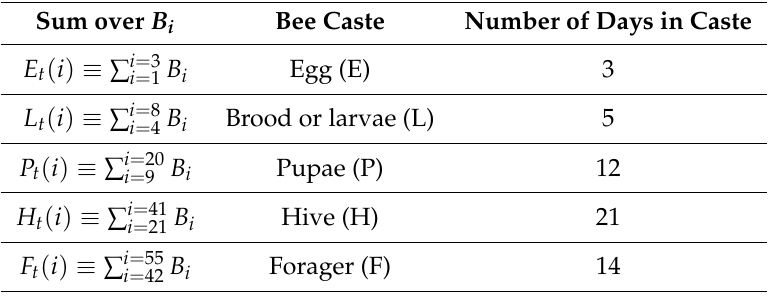
Table 1. Day ranges used to calculate bee